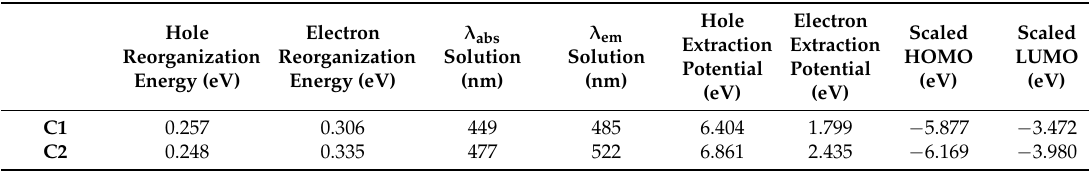
Table 3. Calculated electro-optical parameters for C1 and C2